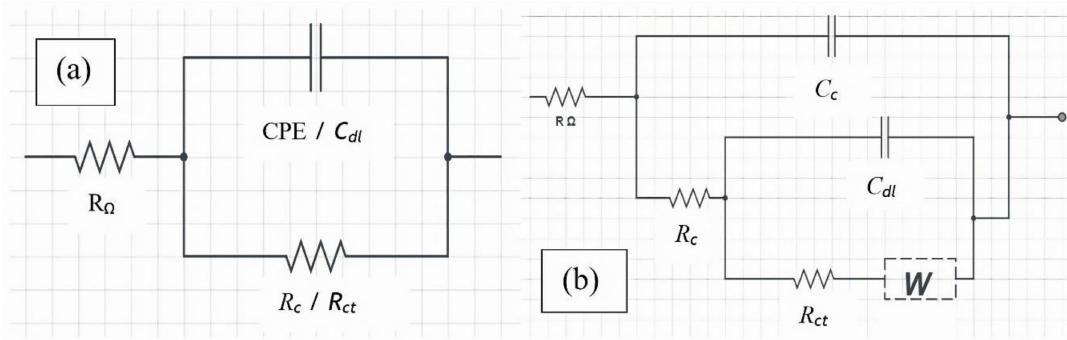
Figure 2. Equivalent electric circuit model for ( a ) bare and ( b ) coated